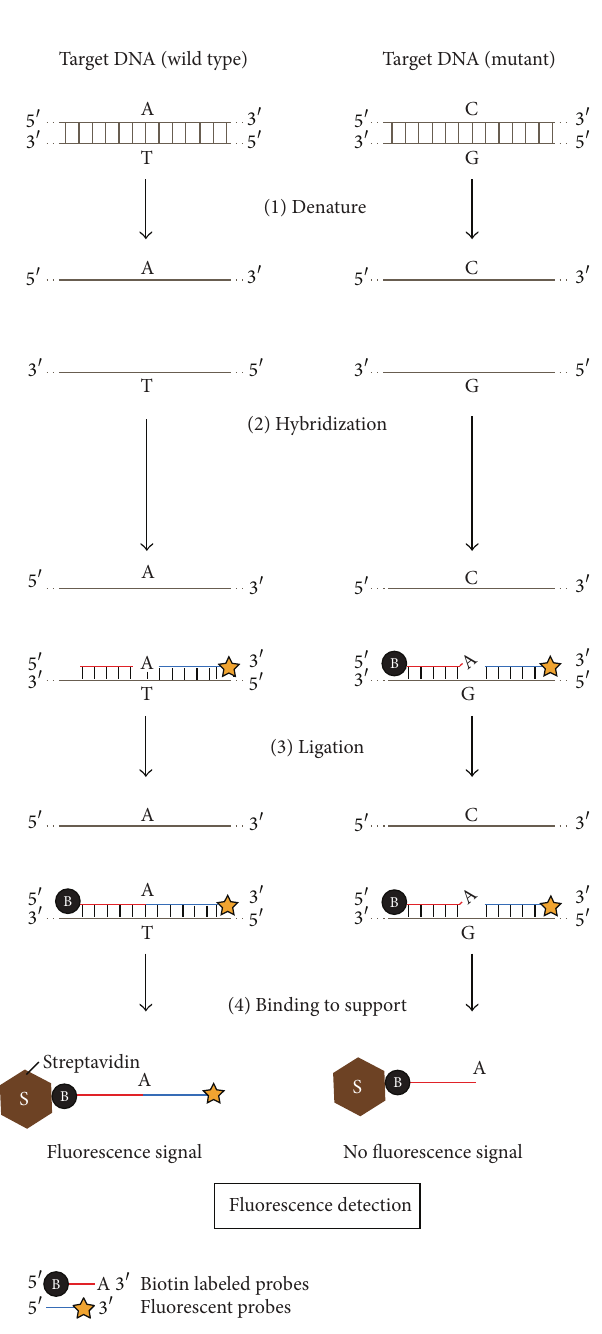
Figure 3: Schematic diagrams for the Oligonucleotide Ligation Assay (OLA). DNA fragments from the normal type and the mutant type (at the single nucleotide polymorphism (SNP) site) are shown as reaction templates. (1) Denature: samples are heated to 85–95 ∘ C for one to several minutes to denature (separate into single strands) the target DNA. (2) Hybridization: two oligonucleotide probes, 5 󸀠 -biotin labeled probes and 3 󸀠 -fluorescent (or radiolabeled) probes, which are complementary to the normal-type target, hybridize to the target DNA fragment. (3) Ligation: adjacent probes that are perfectly complementary to the target (left) are connected by DNA ligase. (4) Binding to support: the fluorescently labeled ligation samples are immobilized to streptavidin and detected by fluorography only if ligated to biotinylated oligonucleotides that can be bound to streptavidin on a solid support